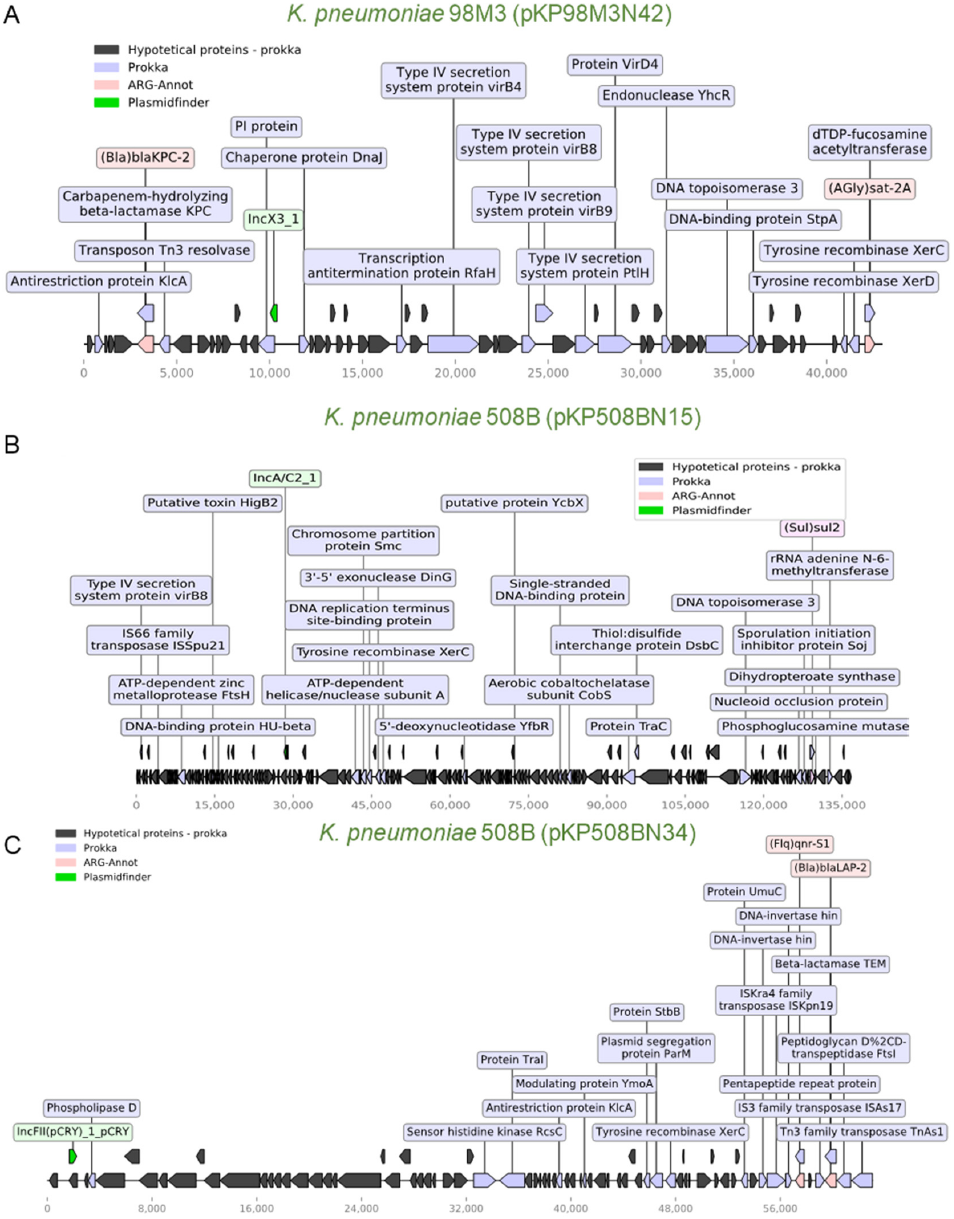
Figure 4. Schematic representation of genes of three K. pneumoniae plasmids. ( A ) Plasmid pKP98M3N42 (43 kb) from K. pneumoniae 98M3. This plasmid carries two ARGs ( bla KPC-2 and sat-2A ), elements of a type IV secretion system, two resolvases, and a Tn3 transposase. This plasmid is very similar to pKP125M3N44 from K. pneumoniae 125M3 (Figure S4A). Whole-plasmid visualization was performed using a python module for prokaryotic genome analyses (DnaFeaturesView) and a matplotlib module combined, as well as ARG-ANNOT and Prokka’s results [49]. ( B ) Plasmid pKP508BN15 (136.8 kb) from K. pneumoniae 508B transports sul2 and an rRNA adenine n-6-methyltransferase ( ermC ) resistance marker. A transposase, a xerC recombinase, and a type IV secretion system virB8 protein are also found in this plasmid. ( C ) Plasmid pKP508BN34 (63 kb) is also from K. pneumoniae 508B and carries several transposases and two resistance determinants, qnr-S1 and bla LAP-2 . Legends represent the colors code for the identified